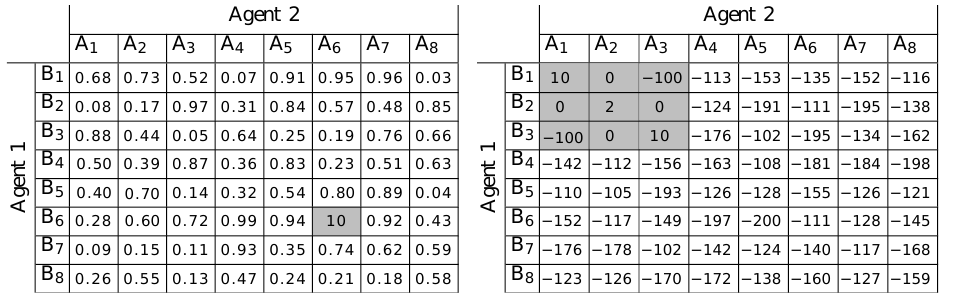
Figure 6. Random ( left ): A game matrix having an optimal action combination with value 10. Negative penalties ( right ): A game matrix having high penalties for all action combinations in addition to the original penalty game